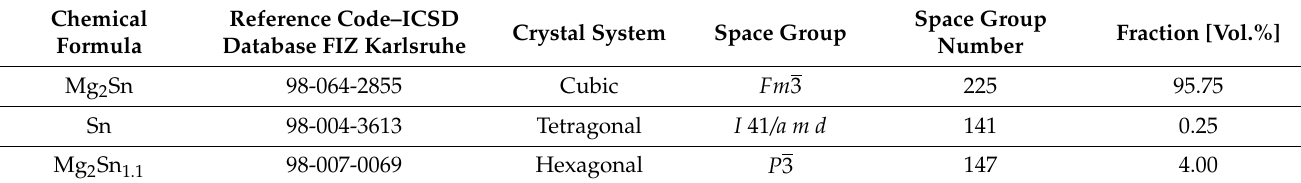
Figure 2. XRD pattern of as-cast Mg 2 Sn alloy. Table 3. Phases identified during the XRD analysis of the powdered Mg 2 Sn alloy.